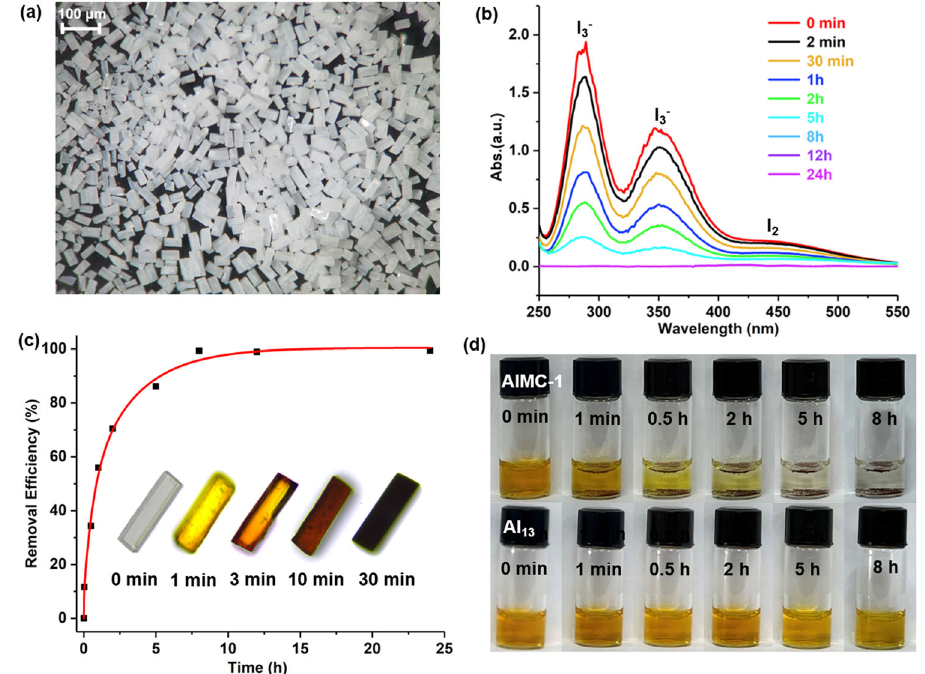
Fig.5|IodineremovalbyAlMC-1crystalsin400ppmI 2 /KIaqueous.a Uniformly sized single-crystal adsorbents (~50 μ m) ready for removing iodine from water. b Time-dependent UV – Vis spectra upon the addition of AlMC-1 . c The iodine adsorptionremovalef fi ciencyisbasedontheabsorptionpeakat286nm.Inset:The